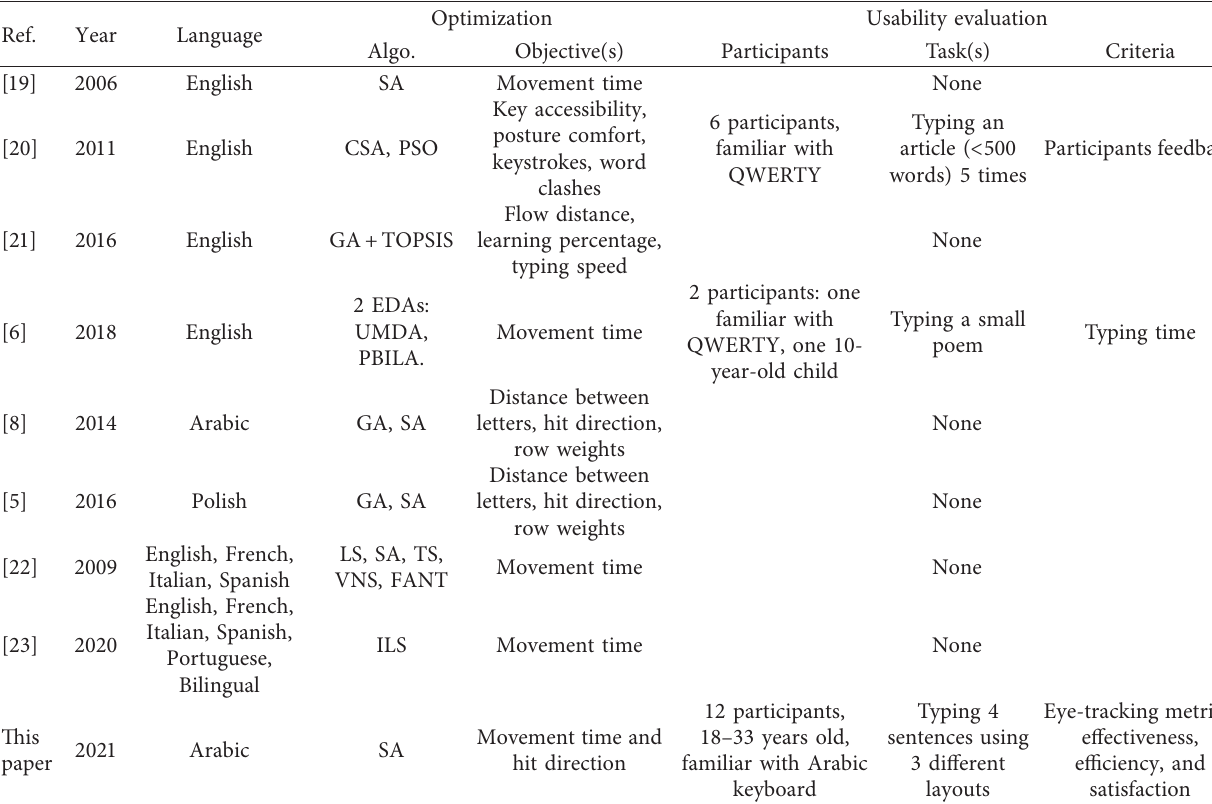
Table 1: Summary of some of the existing studies on the optimization of single-pointer keyboard.